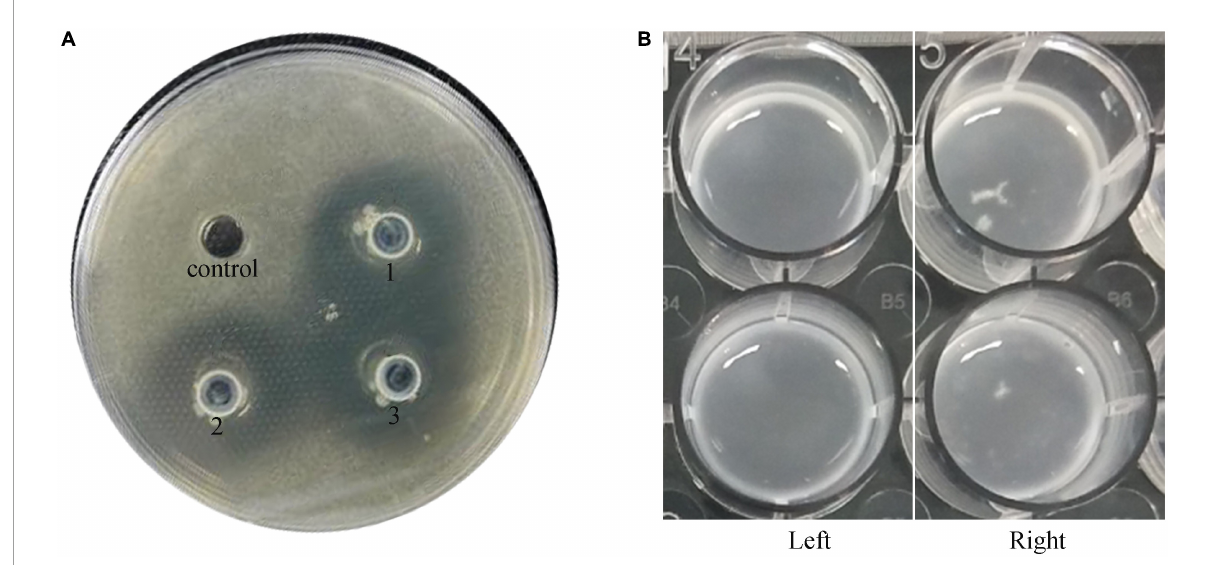
FIGURE1 Microbial activity of investigated strain. (A) Double-layer plate assay: control: blank; experimental group: 1, 2, and 3. (B) Agglutination test: left, blank; right, experimental